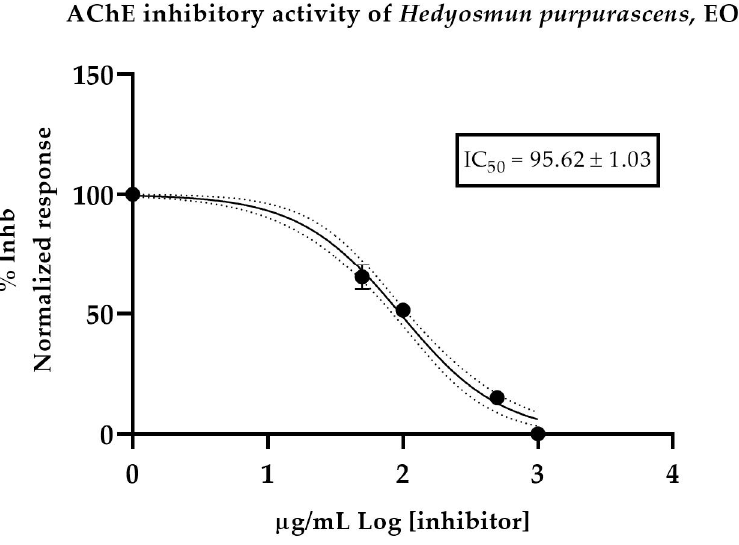
Figure 2. Half-maximum inhibitory concentration of H. purpurascens EO against acetylcholinester- ase.